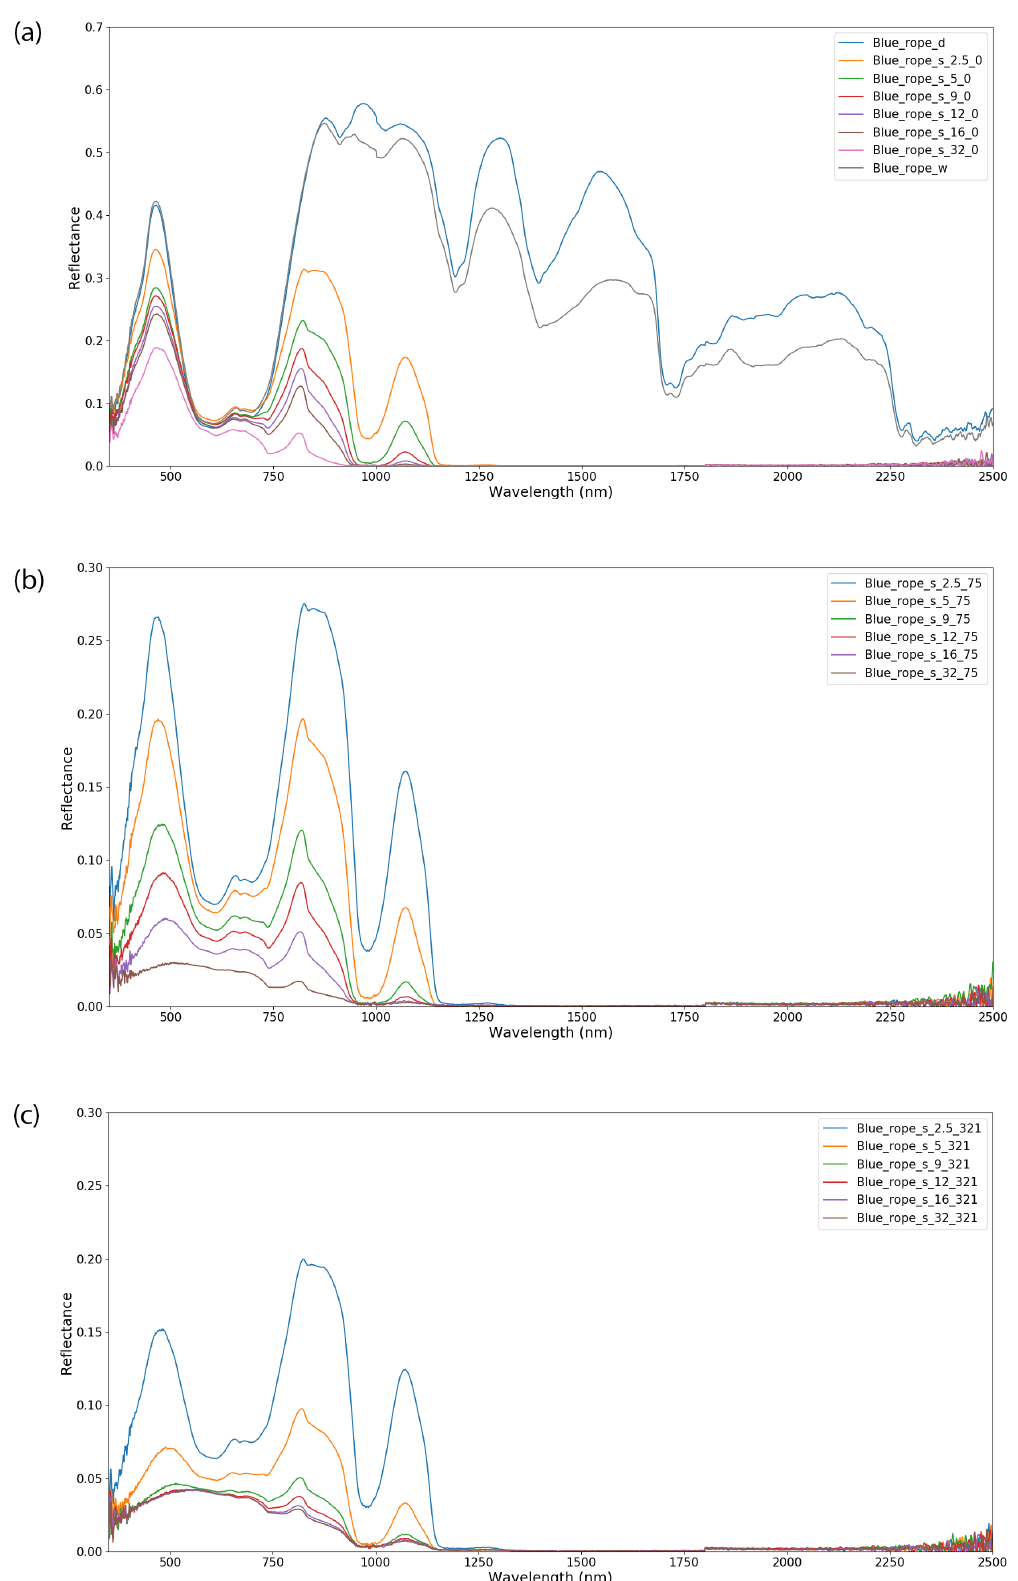
Figure 9. Spectral reflectance of the blue rope submerged in (a) clear water, (b) water with a TSM concentration of 75mgL − 1 and (c) water with a TSM concentration of 321mgL − 1